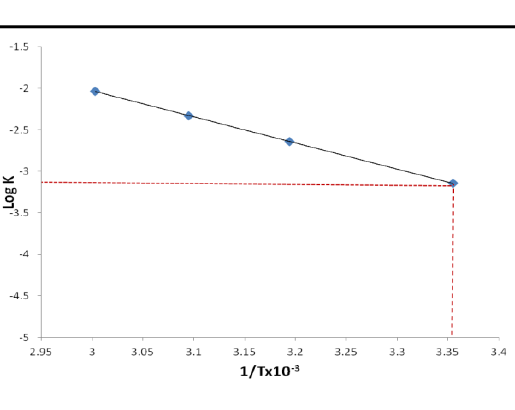
Figure11: Arrhenius plot of aspirin for estimation of shelf life